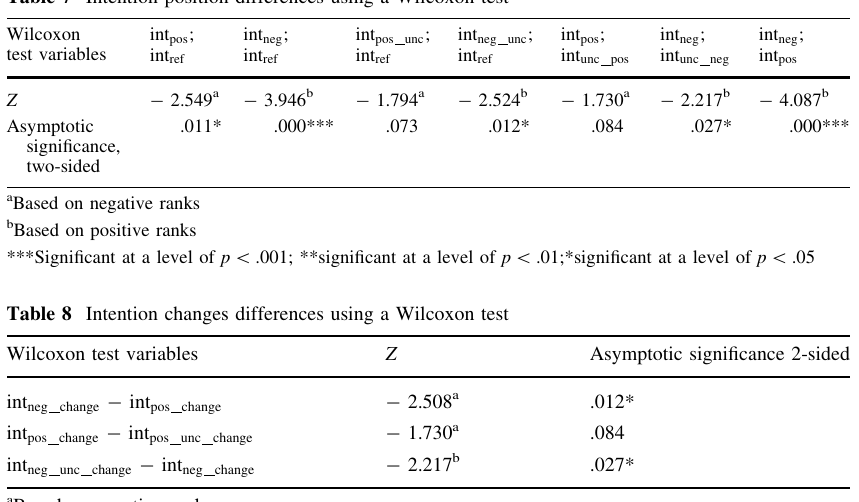
Table 7 Intention position differences using a Wilcoxon test